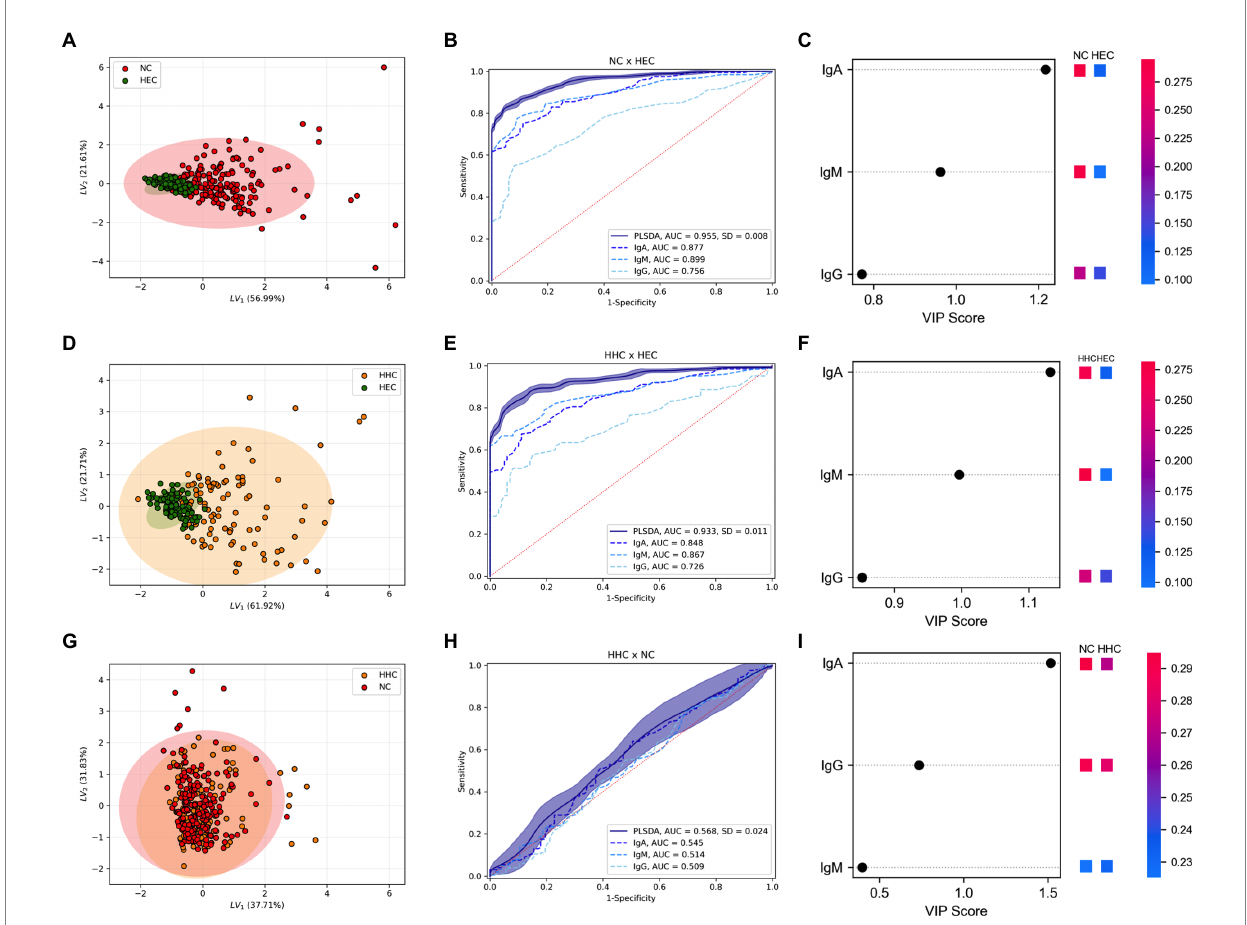
FIGURE 2 Simultaneous analysis of α -Mce1A antibodies in the clustering of groups. Partial least squares-discriminate analysis (PLS-DA) plot of IgA, IgM and IgG α -Mce1A combined from HEC, HHC, and NC. PLS-DA score scatter plots for HEC (green) and NC (red) (A) ; HEC and HHC (yellow) (D) ; HHC and NC (G) . Rank of the different immunoglobulins identified by PLS-DA according to the Variable Importance in Projection (VIP score) on the x-axis. The colored boxes on the right indicate the relative levels of the corresponding antibody (OD) in each group under study (C,F , and I) . Receiver operating characteristic (ROC) curve for schematic performance of PLS-DA classifiers over the validation set for combined antibodies and isolated levels in the NC and HEC (B) , HHC and HEC (E) , HHC and NC (H) groups. HEC, healthy endemic controls; HHC, household contacts of HD patients; NC, new cases of HD; IgA, immunoglobulin A; IgM, immunoglobulin M; IgG, immunoglobulin